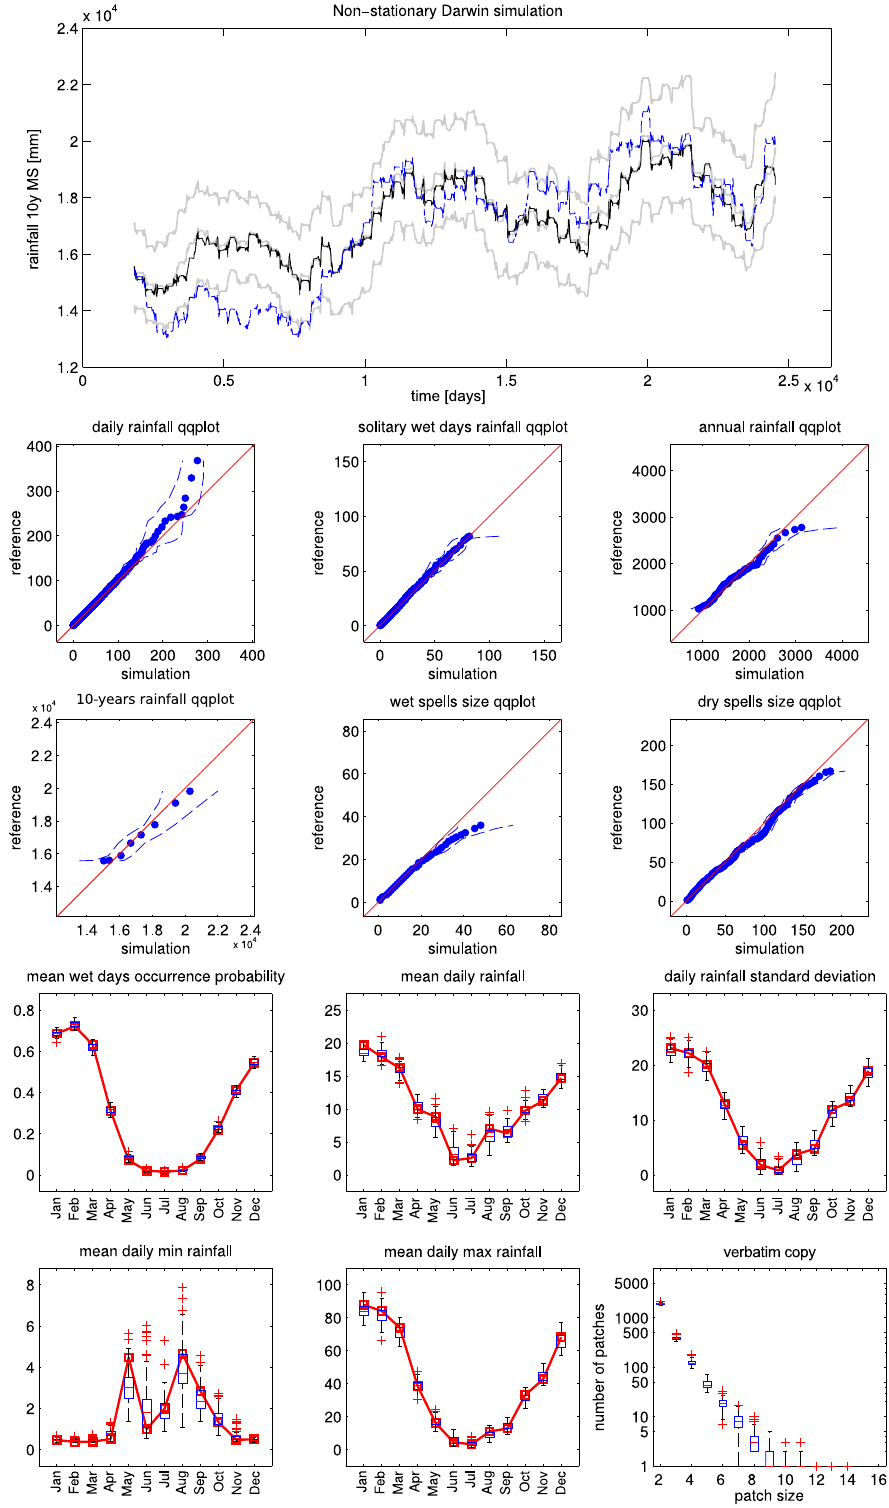
Figure 9. Darwin daily rainfall nonstationary simulation: 10-year moving sum time series (top panel) of the reference (black line), median, 5th and 95th percentiles of the realizations (gray lines) and a randomly picked simulation (dashed blue line); main quantile comparisons (center panels); main seasonal indicators and verbatim-copy box plots (bottom).